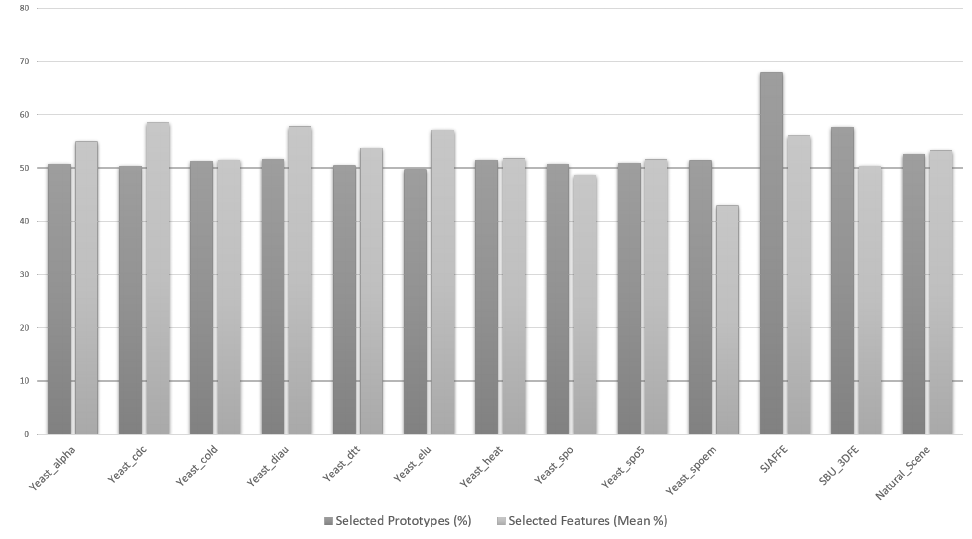
Figure 3. Number of selected prototypes and features